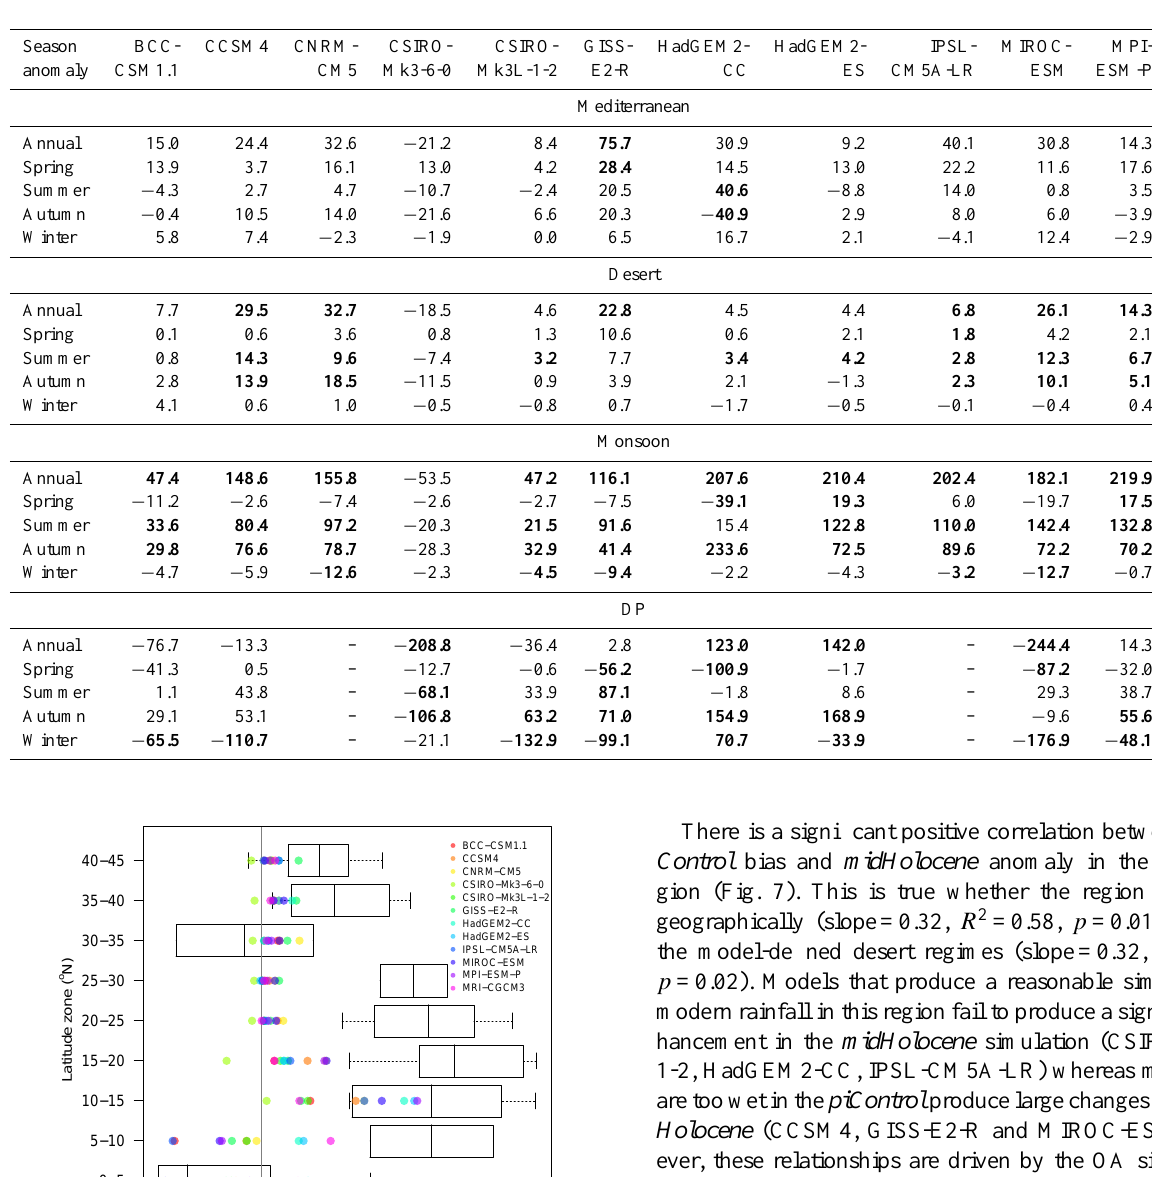
Table 2. Summary of area-averaged climate anomalies ( midHolocene minus piControl ) for individual models for individual seasons and for mean annual precipitation. Bold font indicates values that are significantly different from the interannual variability of the modern observations. The seasons are spring, summer, autumn, and winter (as in Sect. 3.1).